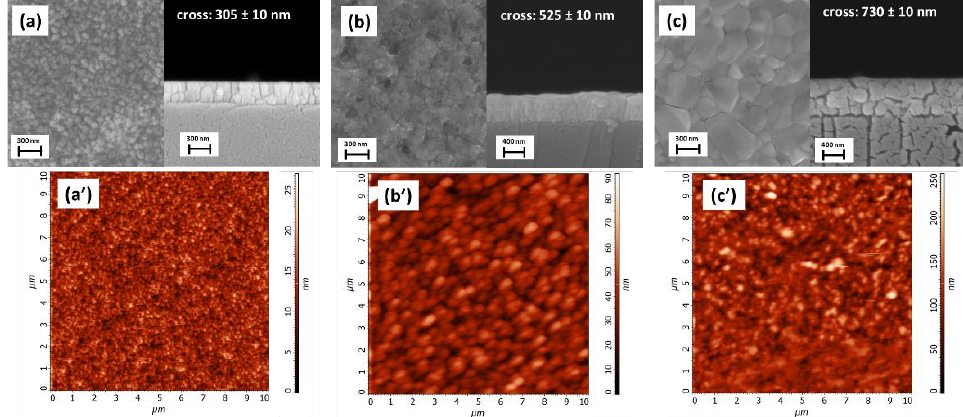
Figure 8. FE-SEM plan view and cross-section images of ( a ) ITO_quartz substrate; ( b ) Cu 2 O thin film deposited at 250 °C on ITO substrate; ( c ) MAPI film deposited on Cu 2 O_ITO_quartz substrate. The corresponding 10 μm × 10 μm AFM topographical images ( a’ – c’ ) are also shown.